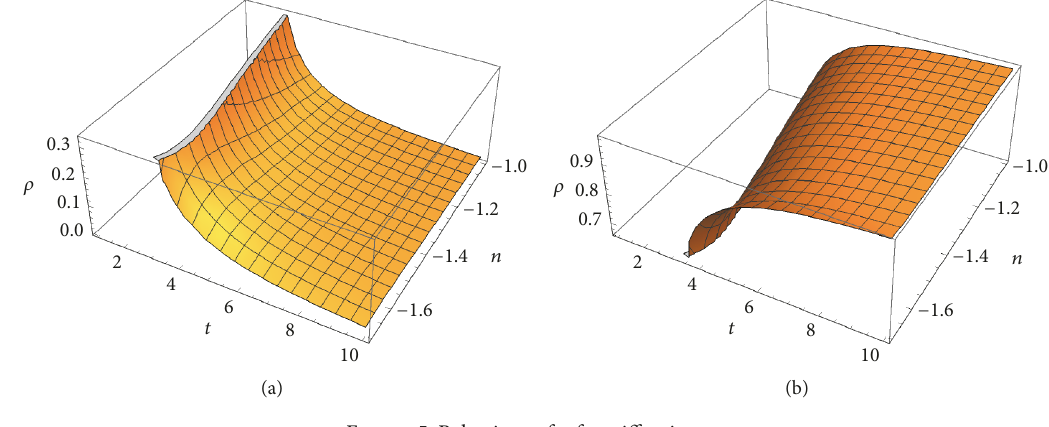
Figure 5: Behaviour of 𝜌 for stiff